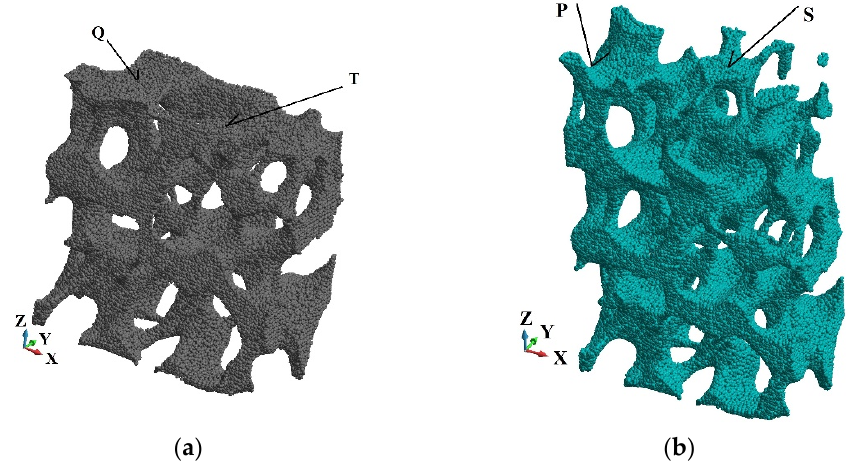
Figure 8. The observed points: ( a ) Cross-section A-A; ( b ) Cross-section B-B.